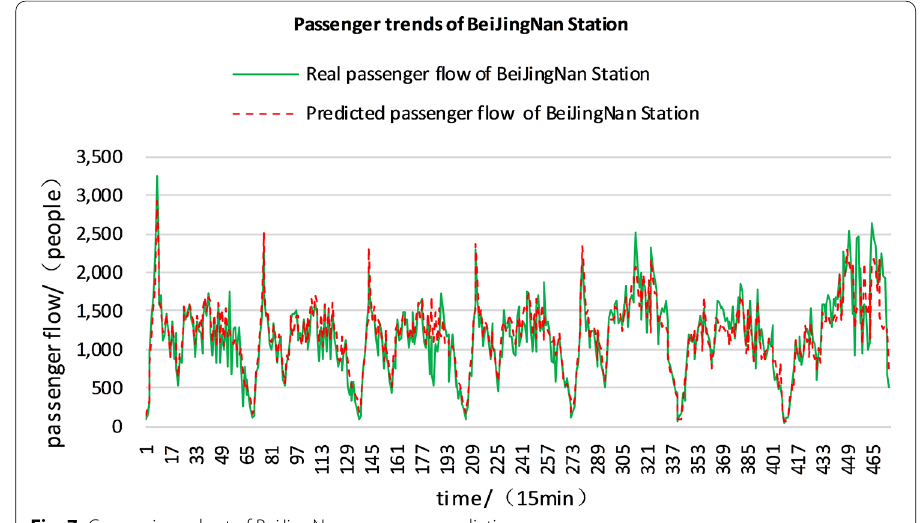
Fig. 7 Comparison chart of BeiJingNan passenger prediction